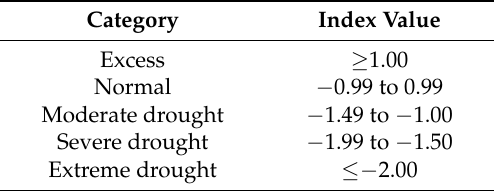
Table 2. Standardized streamflow index (SSI) categories.